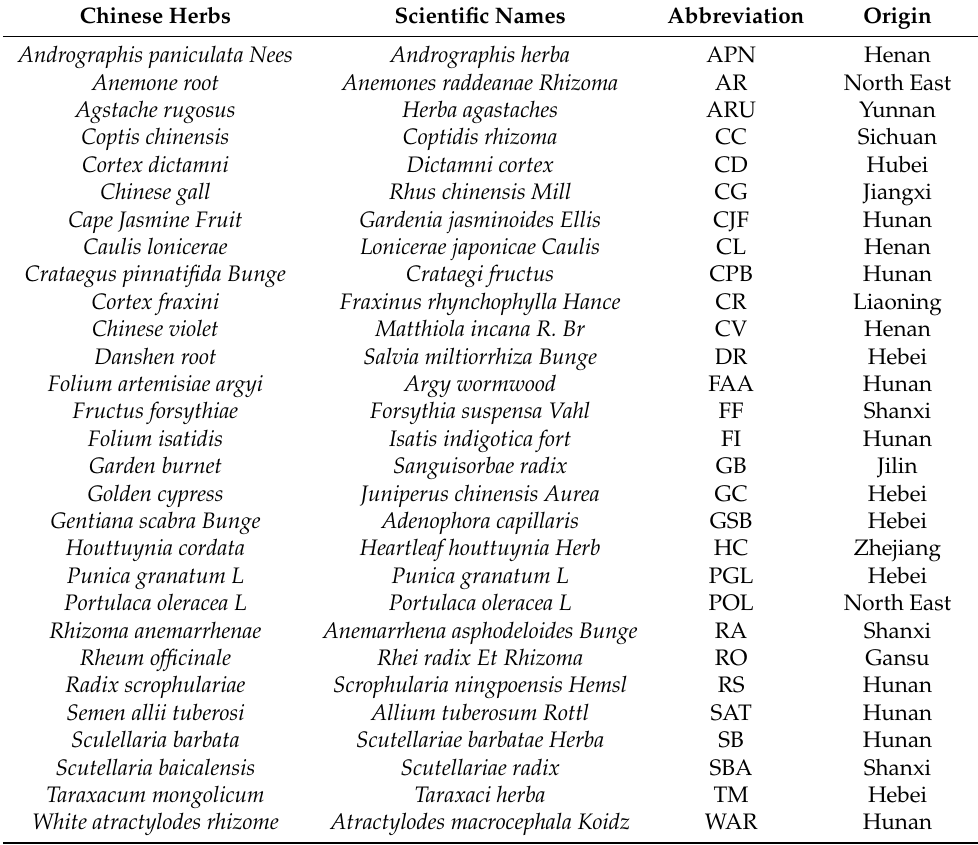
Table 1. Resources of 29 different Chinese